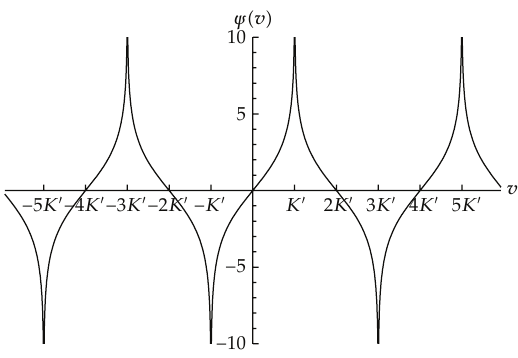
Figure 1: The solution ψ (cid:3) v (cid:4) (cid:8) ln (cid:3)(cid:3) 1 (cid:7) sn (cid:3) v,k (cid:2) (cid:4)(cid:4) / (cid:3) 1 − sn (cid:3) v,k (cid:2) (cid:4)(cid:4)(cid:4) for the Poisson Boltzmann equation. The parameters are k 2 (cid:8) 0 . 75 and K (cid:2) (cid:8) 1 .